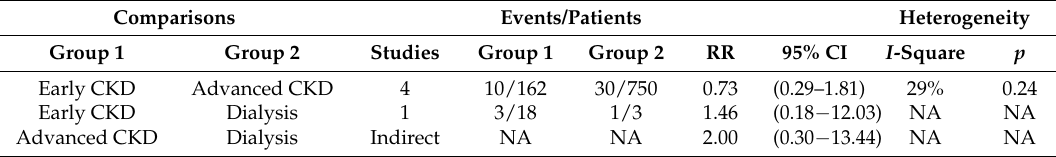
Table 2. Summary of the network meta-analysis for ALT elevation and fever.